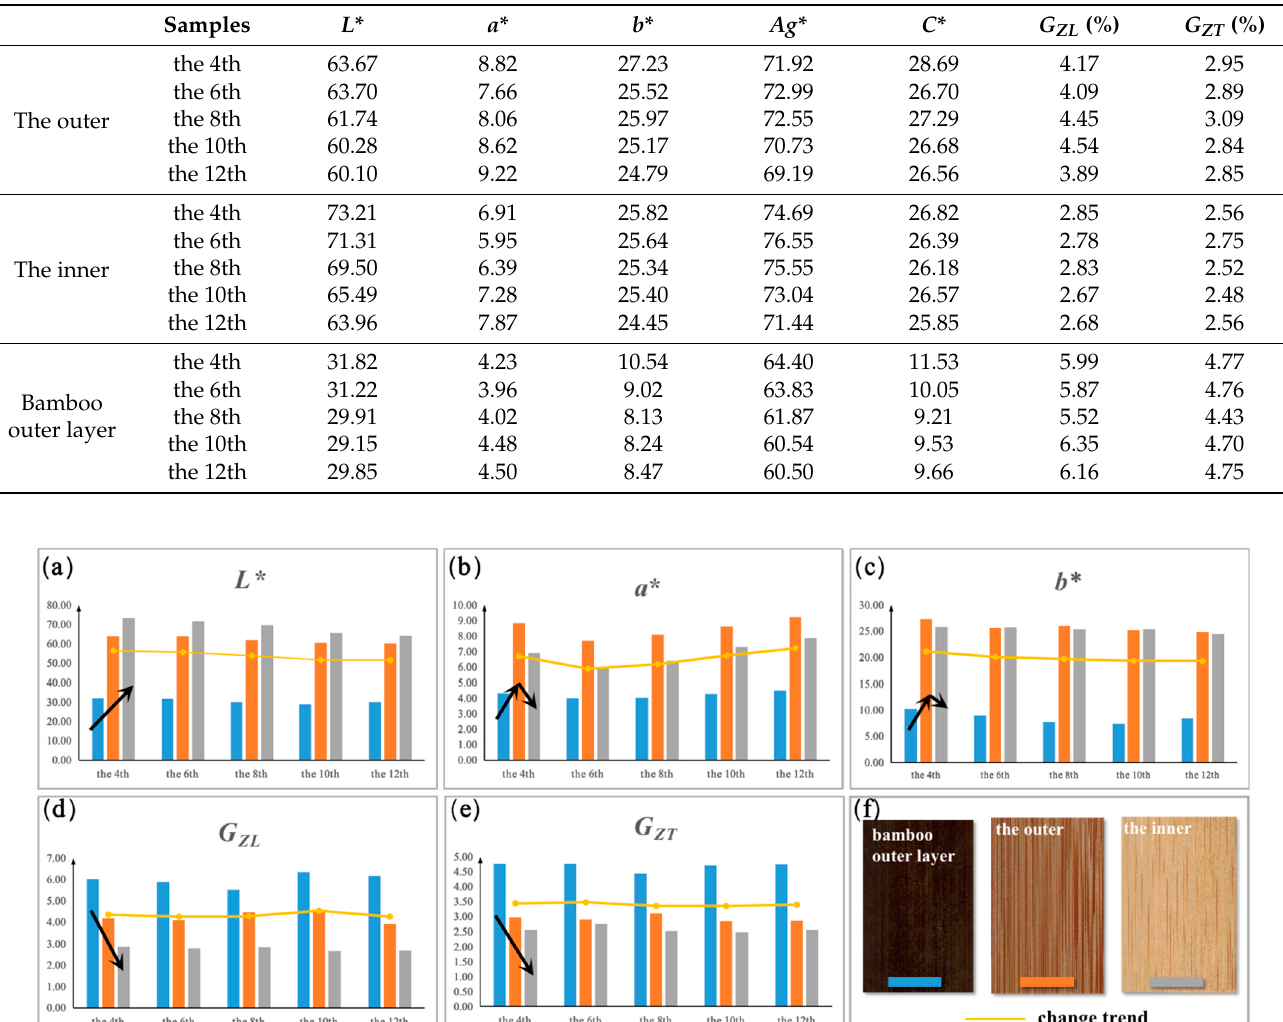
Table 4. The results of color and glossiness of flattened bamboo board surfaces.